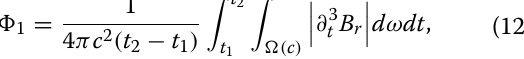
Table 1 Parameters used in data weighting